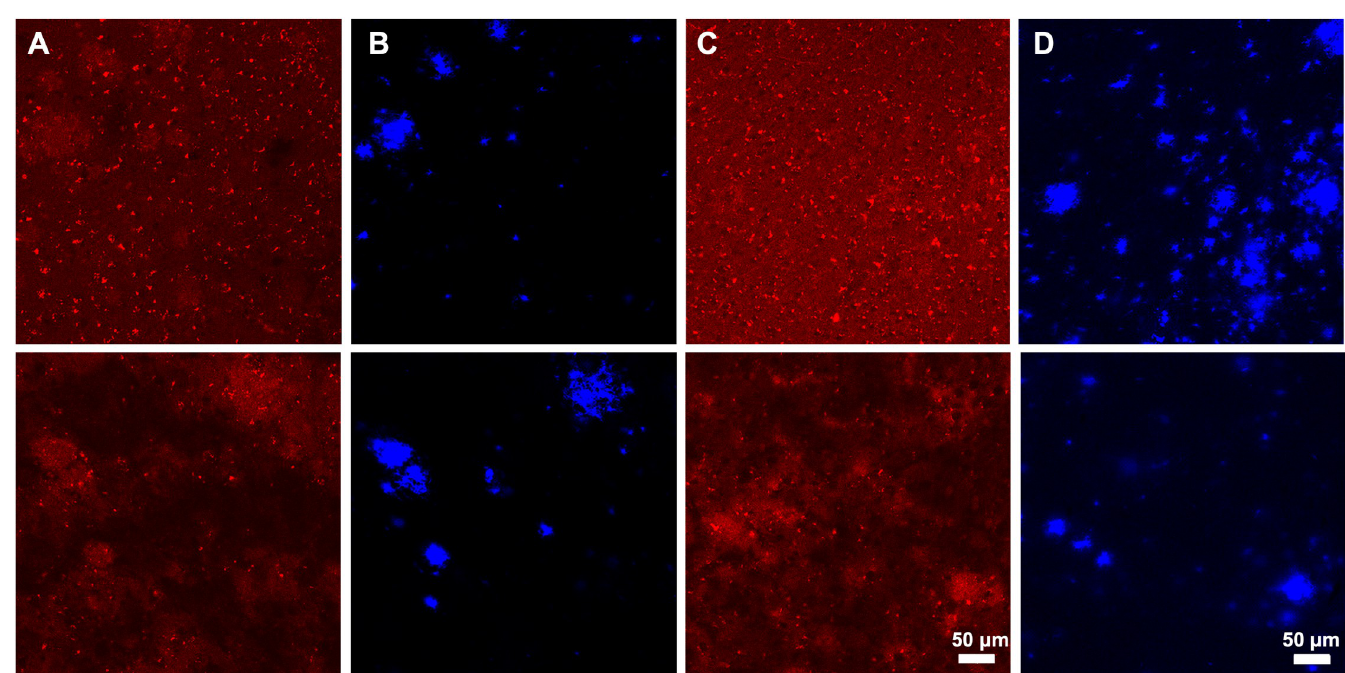
Fig 7. Representative immunofluorescent confocal microscopy of mice brains 2 hours after intravenous injection of Triplet-647. Mice brain sections were stained with X34 which labels the amyloid plaques. Representative 647 channel ( A ) and X34 channel ( B ) microscopy images of mice brains injected with H1-Triplet-647. Representative 647 channel ( C ) and X34 channel ( D ) microscopy images of mice injected with M1 P96H -Triplet-647.